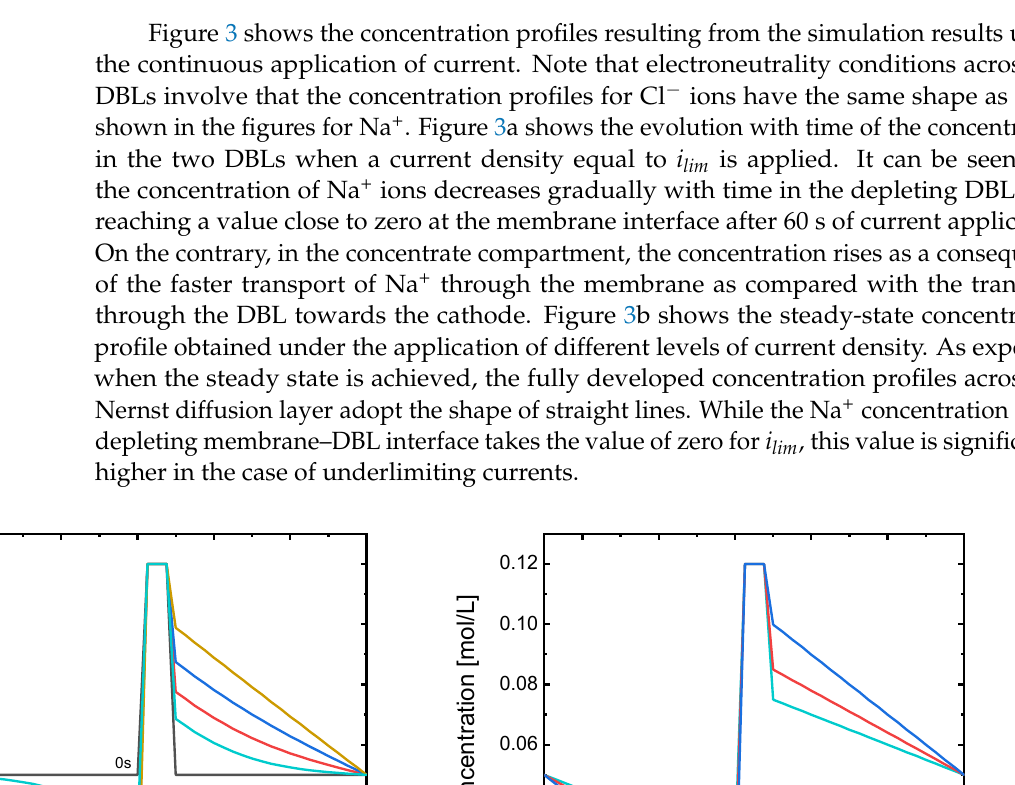
( b ) Figure 4. ( a ) Evolution with time of the NaCl concentration at the interface between the membrane surface and the diluting DBL (position x = 0) for different levels of applied current density; ( b ) evolution with time of the membrane system po- tential drop ( U m ) for different levels of applied current density. 3.2. Effect of Frequency The effect of the frequency of PEF input functions was analyzed at three different levels of current density: 0.7· i lim , i lim and 1.2· i lim . As deduced from the previous subsection, the almost flat evolution of U m with time for 0.5· i lim indicates that the benefits of applying pulse current functions may be minor at very low values of current density. In contrast, the results obtained at 1.2· i lim are expected to be more beneficial in terms of energy savings; although the model can only be used in the unsteady condition for this current, i.e., under the condition that the electrolyte concentration at the depleting membrane–DBL is higher than zero. The duration of the pulses was also selected from the evolution of U m versus